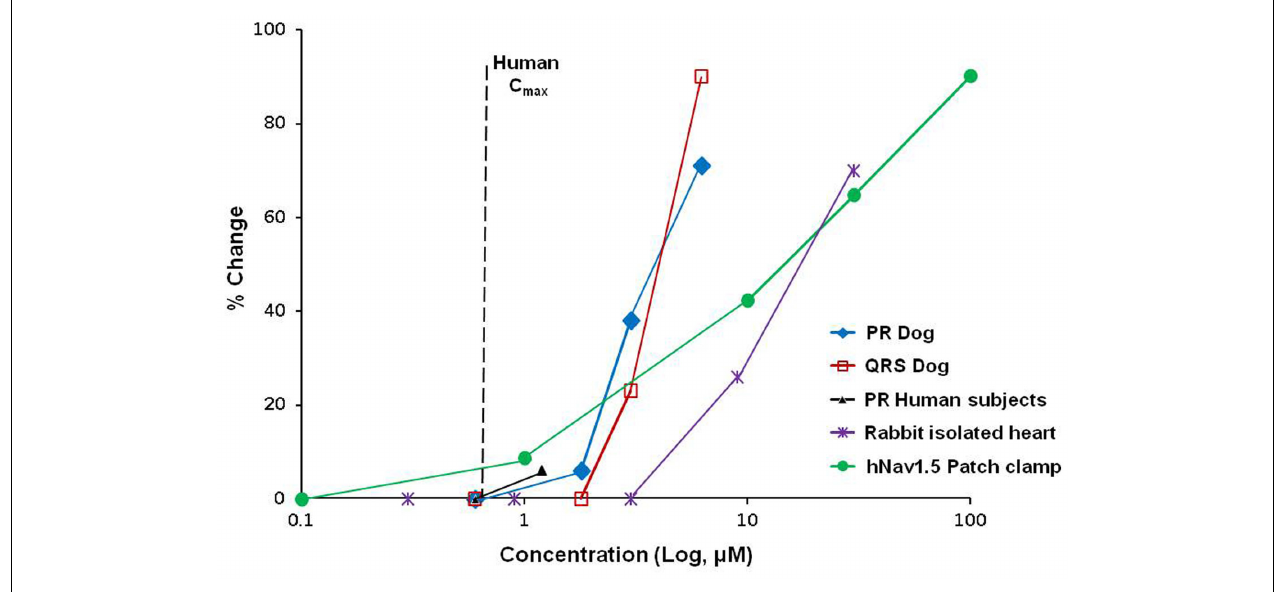
manual patch-clamp. In vivo dog and human data are plotted as maximum free plasma concentration ( C max ). Plasma protein binding of NVP-4 in humans and dogs is 77 and 85%, respectively.Vertical dashed line indicates human free C max at efficacious dose (0.67 μ